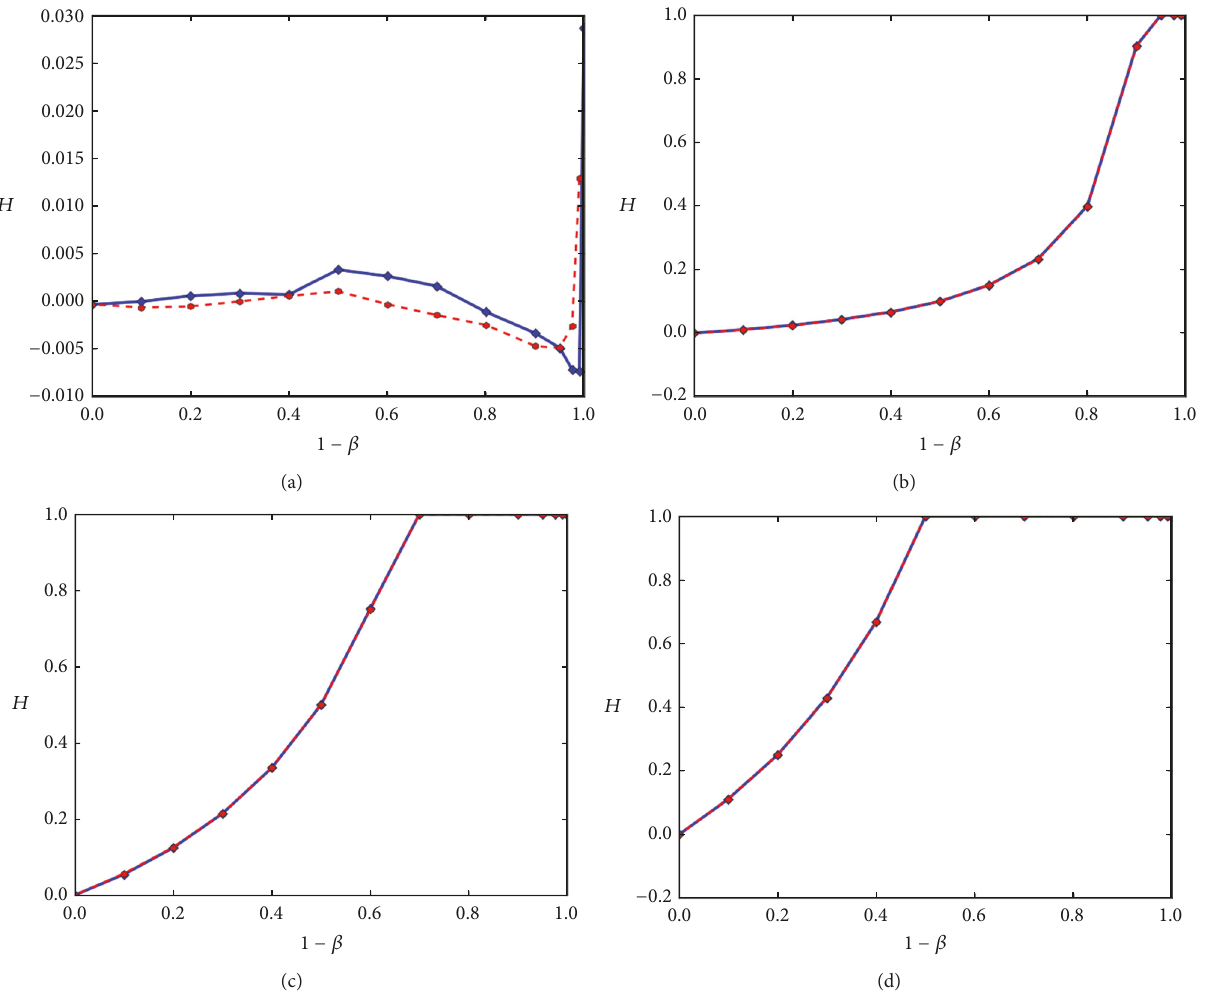
Figure 4: Continuous dilution and repopulation of ferromagnets with different 𝛾 : 0.0 (a), 0.1 (b), 0.5 (c), and 1.0 (d). The red curve represents the dilution, while the blue curve represents the repopulation process. Results have been averaged over different simulation runs.